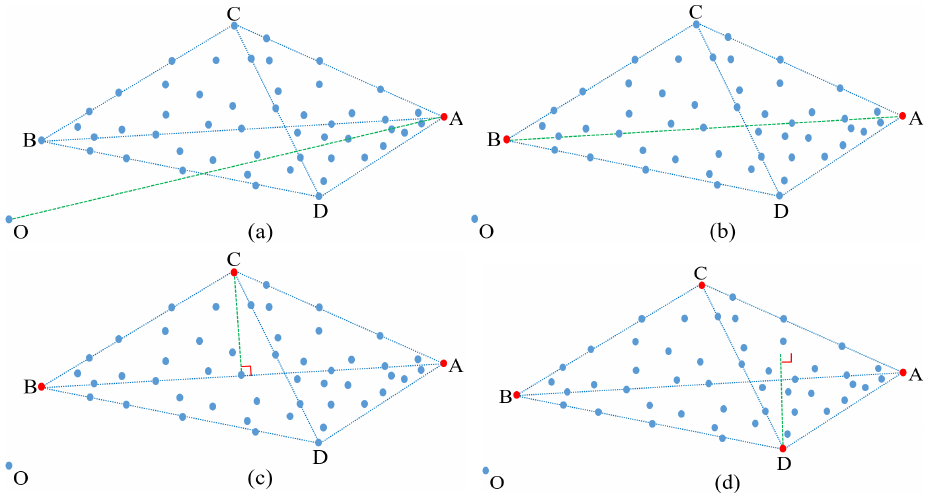
Figure 3. ( a – d ) Step-by-step process illustrating how to extract four endmembers by using our maximum distance analysis (MDA)